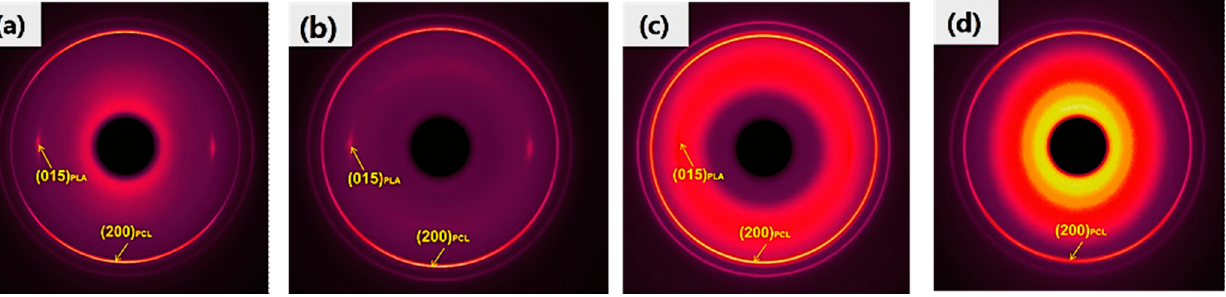
Figure 7. The (200) azimuthal intensity profiles of dispersed phase polycaprolactone (PCL) in mi- croparts with different cavity size and shear layer of macropart. In order to quantitatively determine the sample orientation parameter f , the function of Herman’s orientation [38] was applied here: 𝑓 = 3〈cos (cid:2870) 𝜑〉 − 1 2